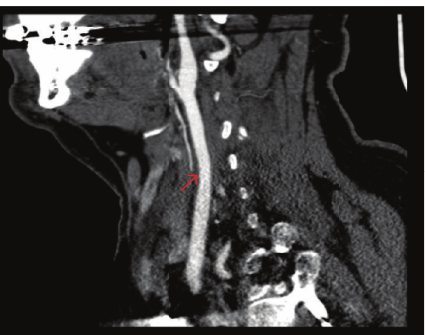
Figure 2: Sagittal CT angiogram of the neck (3 months later) showing very minimal mural thrombus